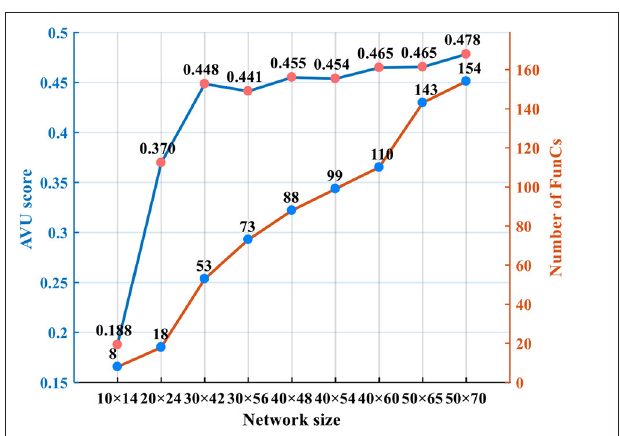
FIGURE 16 | Trade-off between tracking accuracy and resource overhead as the network size increases.